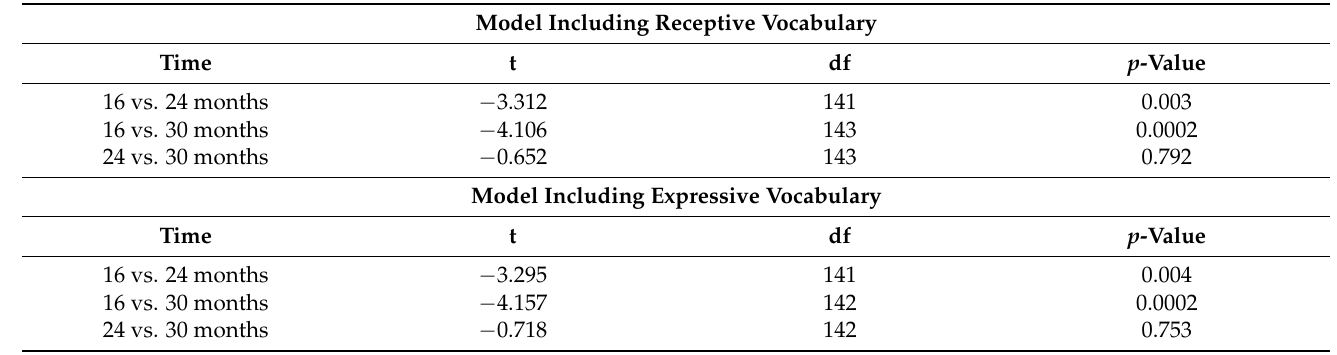
Table 8. Results of post-hoc tests on Analysis of Variance presented in Table